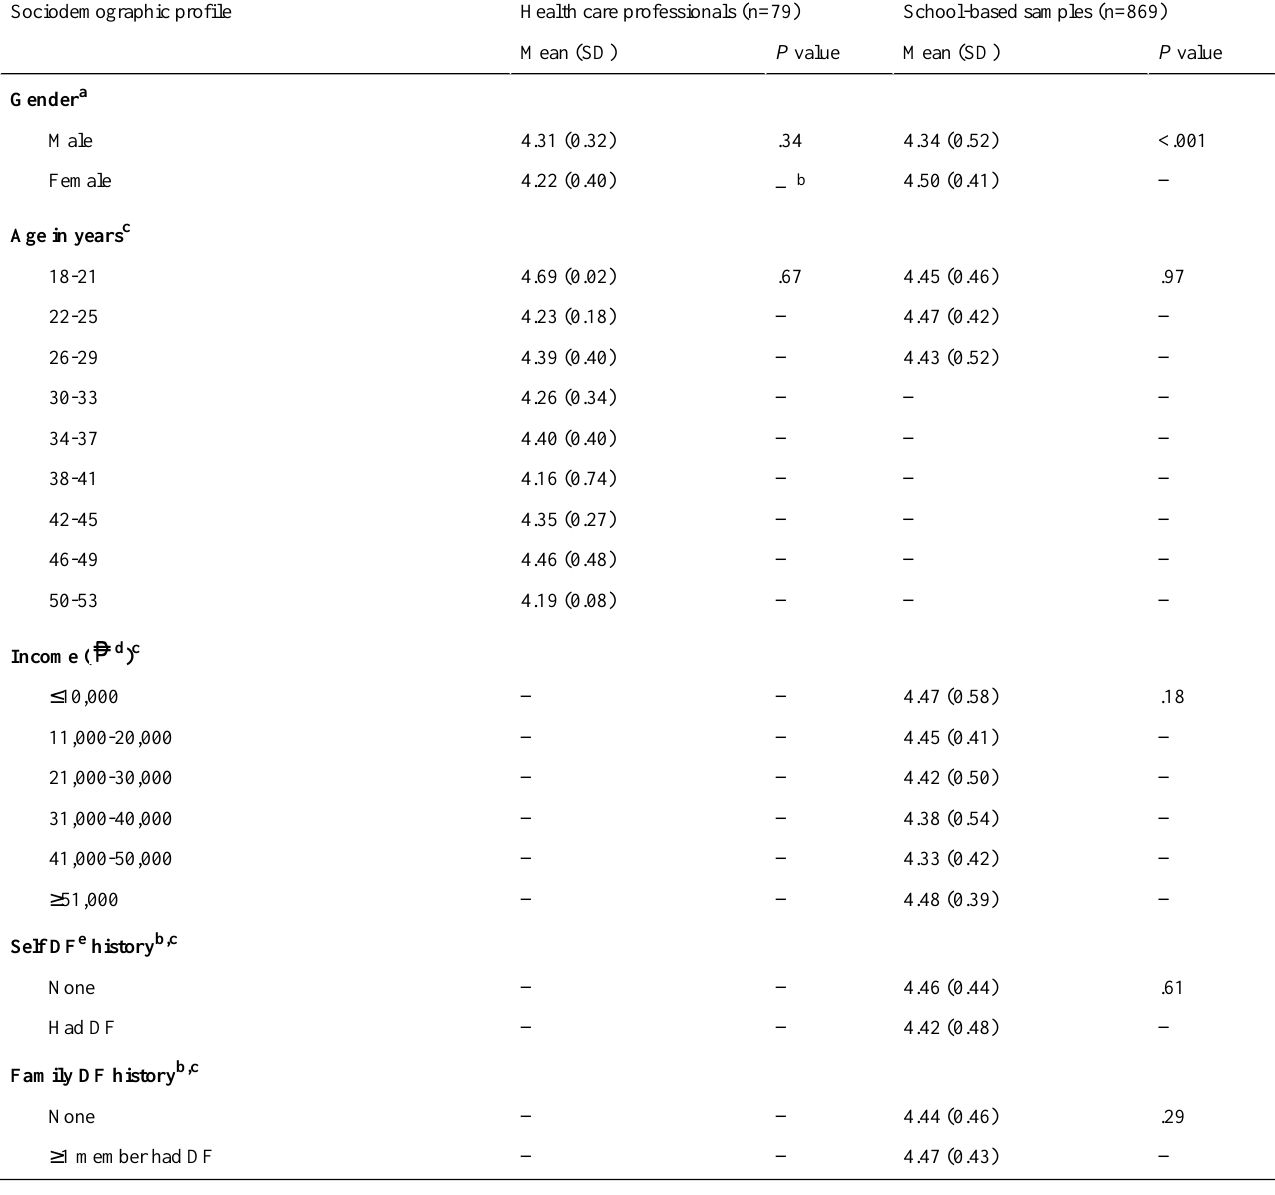
Table 3. Total mean score comparison among health care professionals and school-based samples by sociodemographic and dengue fever